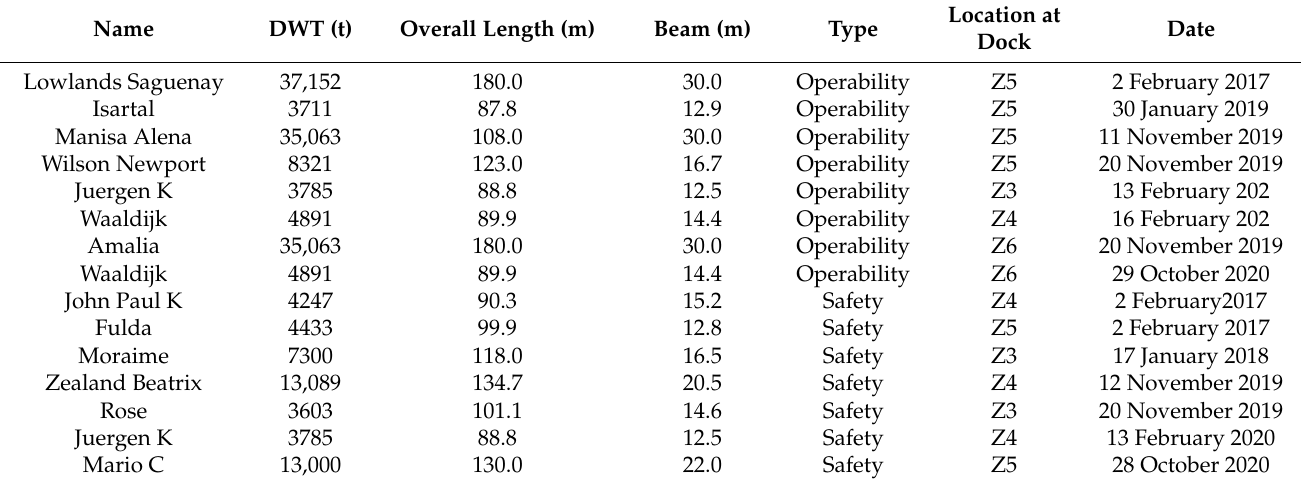
Table 1. Vessel characteristics, berthing area, date, and details of downtime